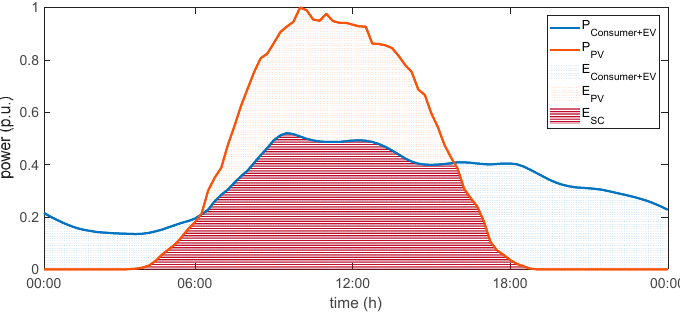
Figure 8. Relevant areas for calculating the DSG, DSS and SCR.